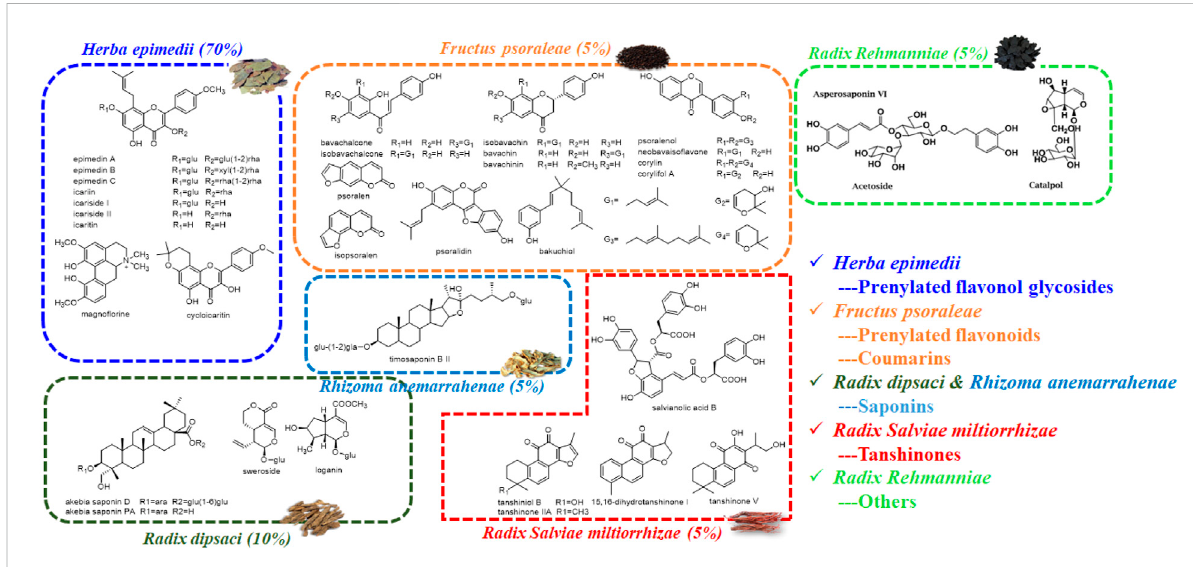
FIGURE 2 Chemical structures of potential bioactive compounds in XLGB based on its chemical pro fi les and metabolic pro fi